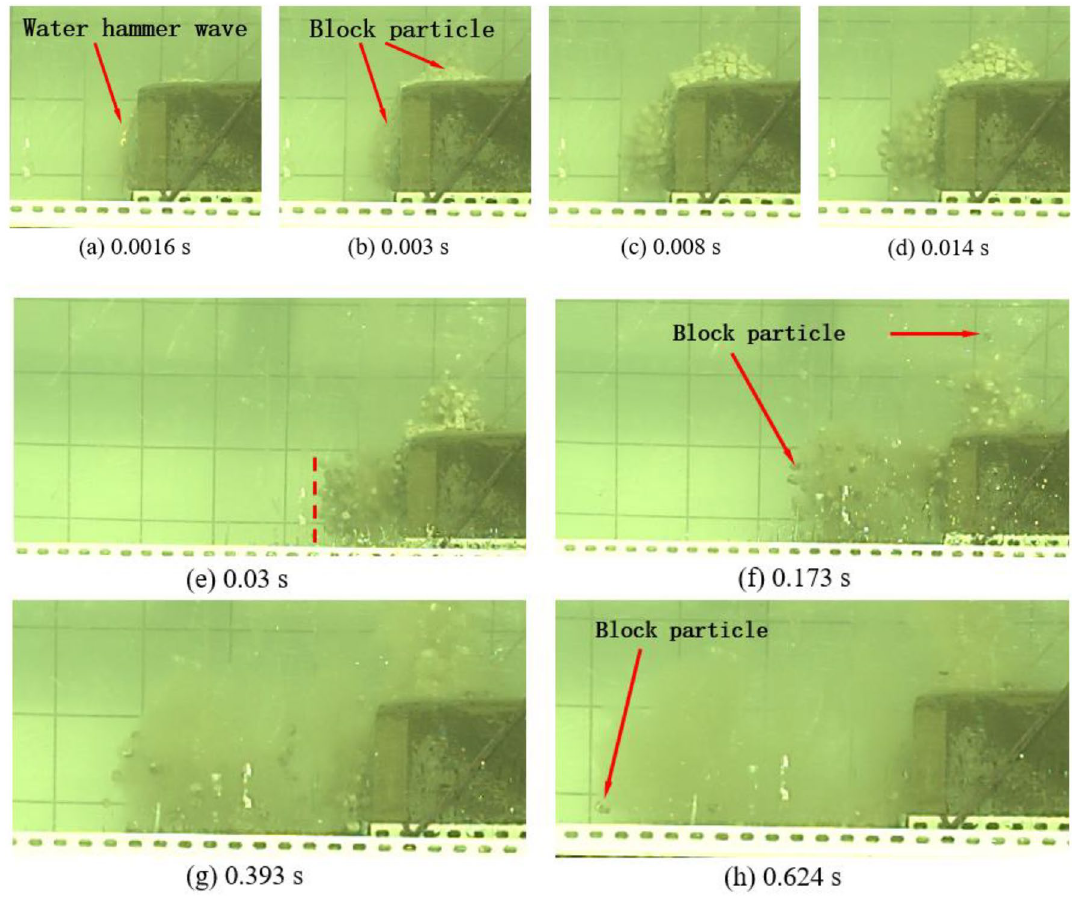
Figure 7. The motion of blocks under a charge of 0.8